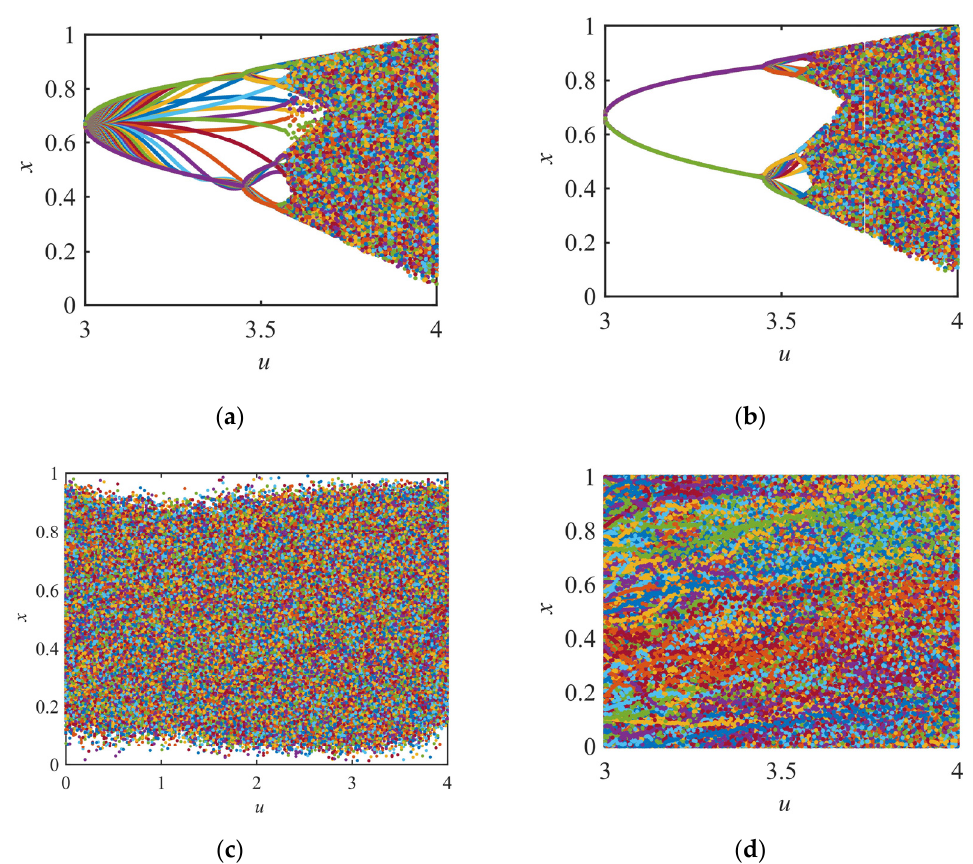
Figure 6. Bifurcation diagrams of ( a ) 2D-CML, ( b ) 2D-NLCML, ( c ) 2D-MCPML and ( d ) 2D-DPRCML.